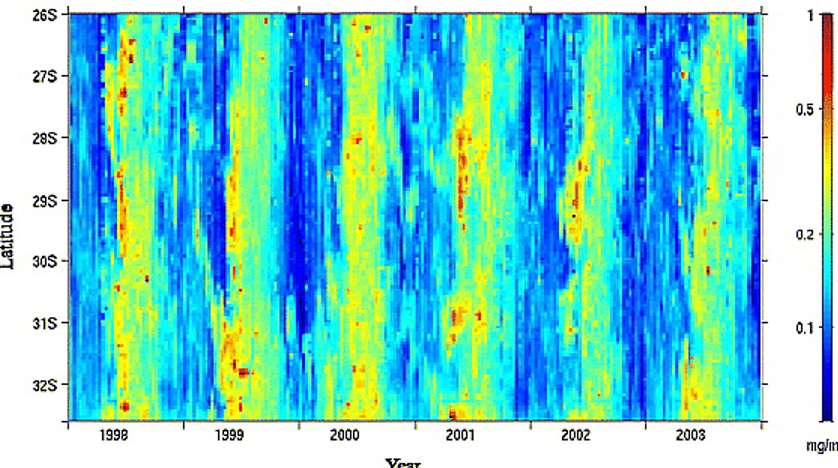
Figure 24. Annual distribution of chlorophyll estimated from SeaWiFS ocean colour data along the shelf break off the west coast of Australia from 26–32 ◦ S, 1998–2003 (from Koslow et al.,